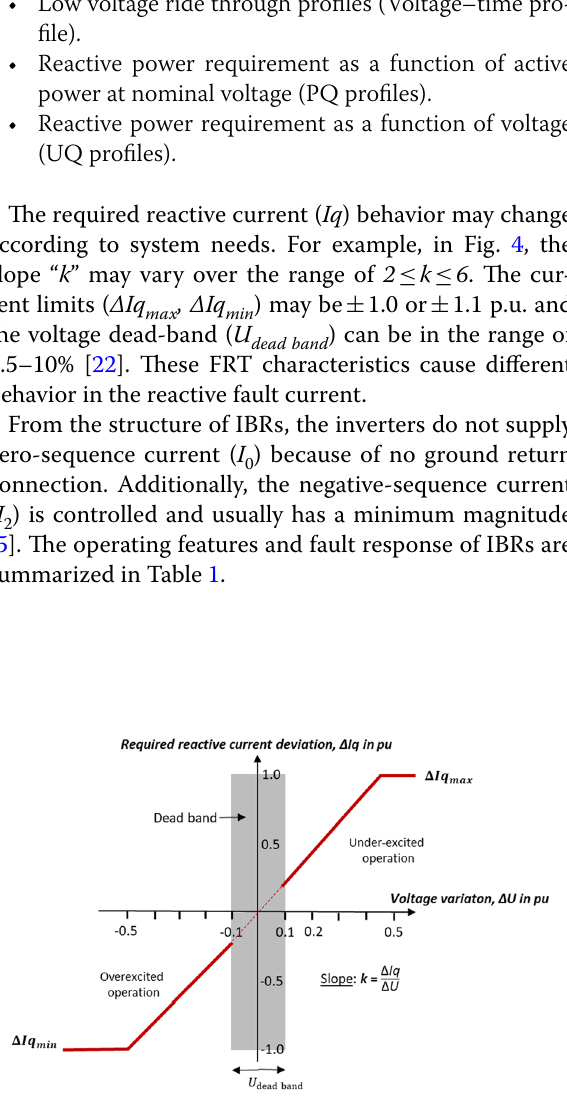
Fig. 3 SC-current features for different sources Fig. 4 Reactive power vs voltage support